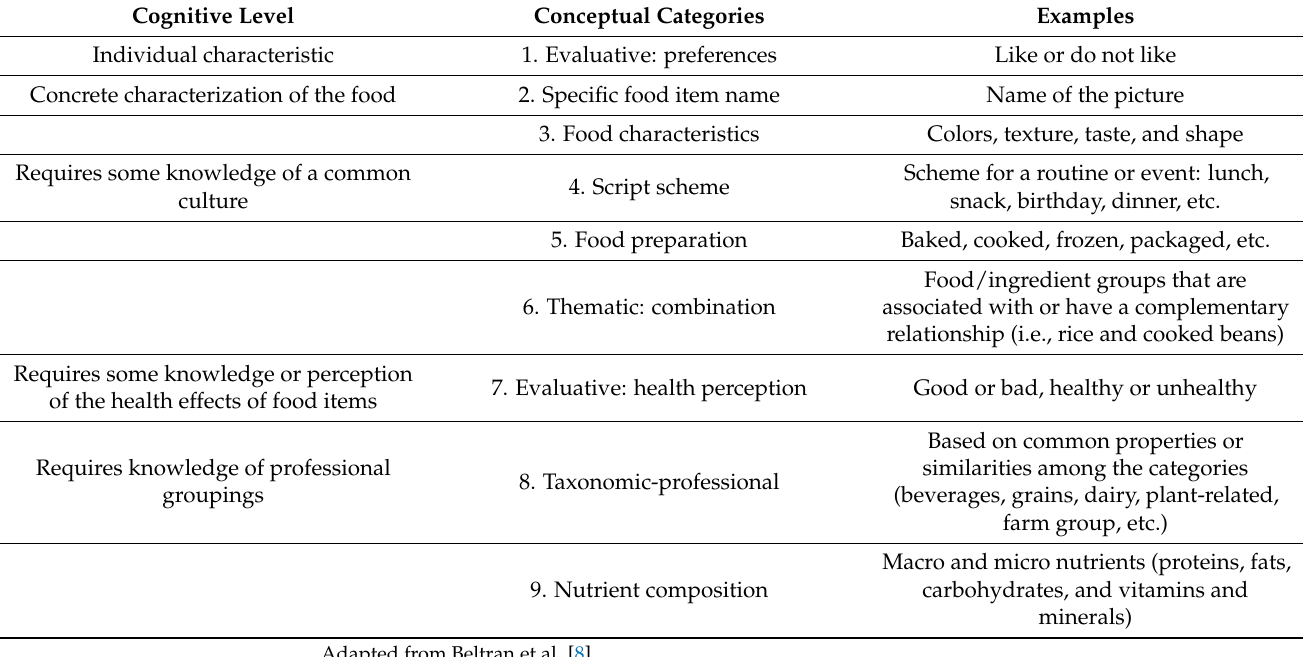
Table 1. Conceptual categories applied in the third-level